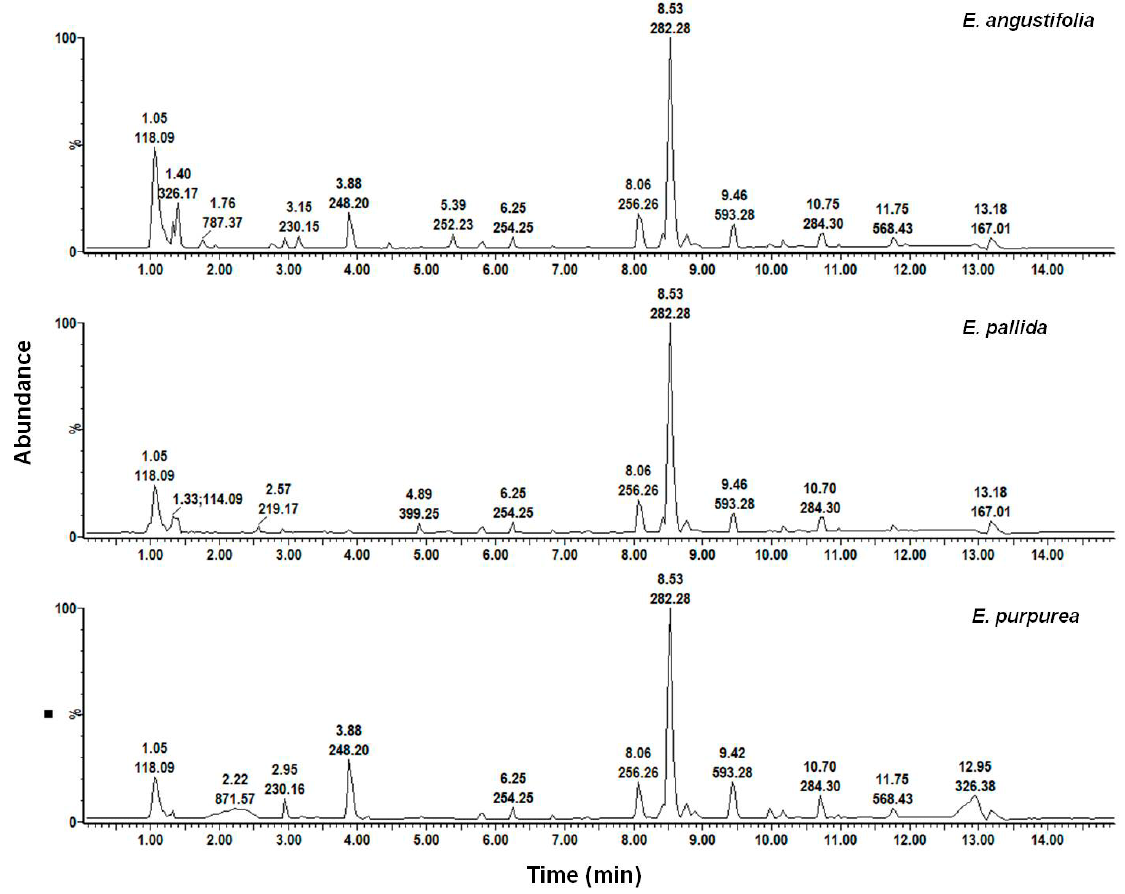
Figure 11. Chromatographic fingerprints of methanol leaf extracts of Echinacea